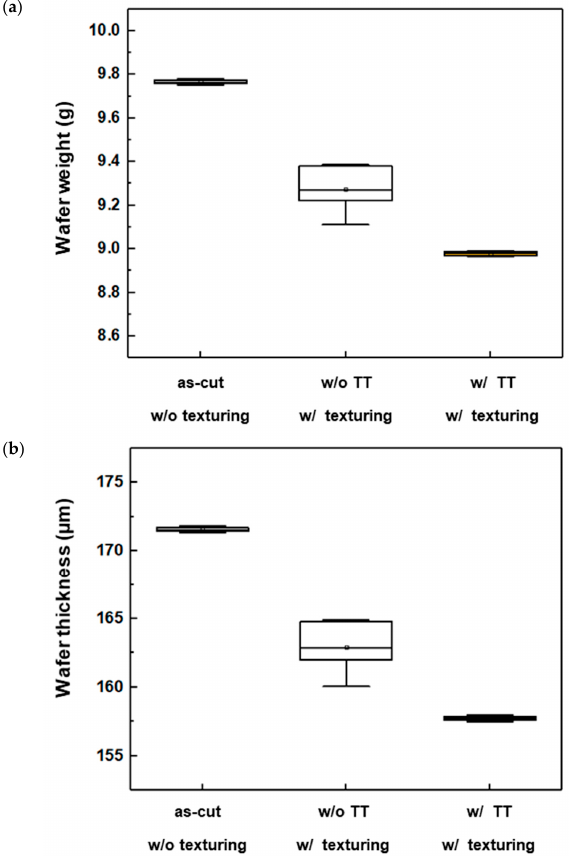
Figure 5. Weight and thickness values of DWS mono-Si wafers: ( a ) Weight (g); ( b ) Thickness